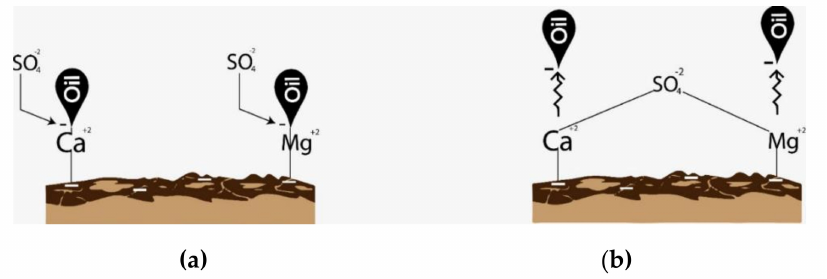
Figure 1. Wettability alteration of sandstone rock surface through the sulfate ions. ( a ) Refers to oil-wet and ( b ) refers to water-wet condition of